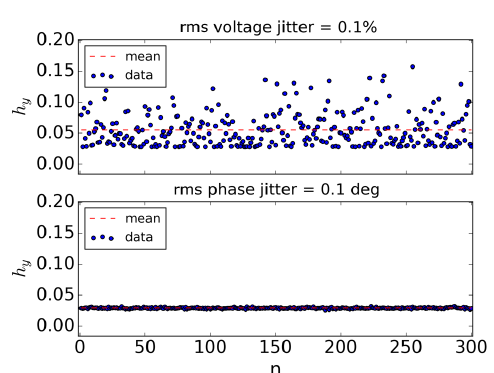
FIG. 9. Same as Fig. 8 except that only the RFD phase jitter is